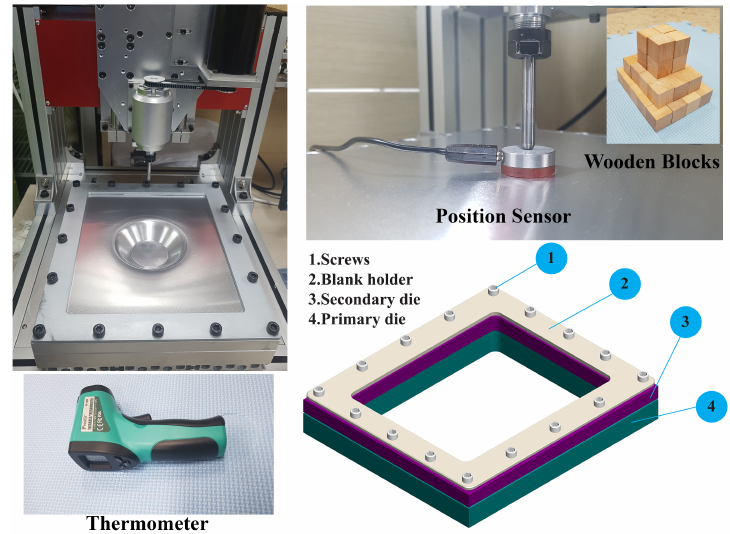
Figure 2. Experimental procedures of the single-point incremental forming process.